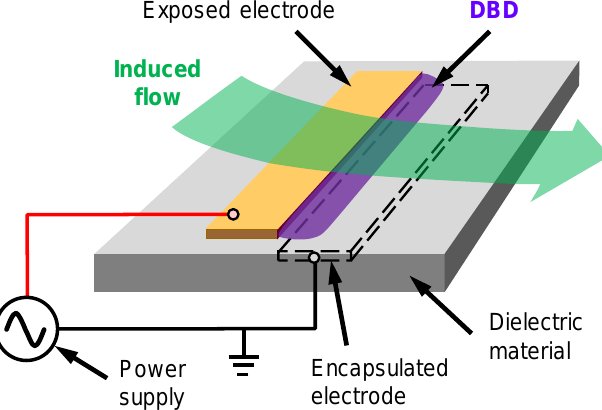
Figure 2. Schematic illustration of dielectric barrier discharge (DBD) plasma actuator.